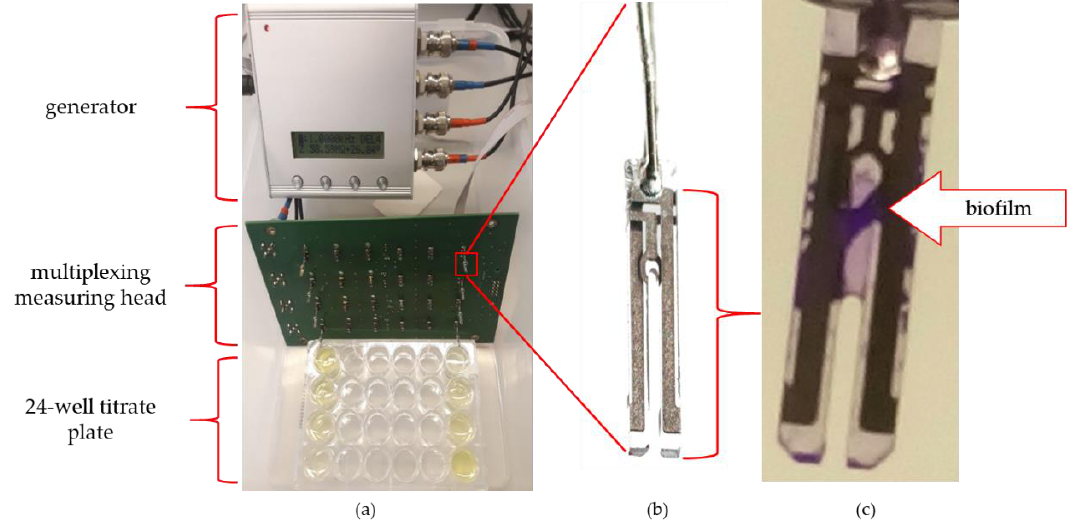
Figure 1. The measurement setup: ( a ) measurement system; ( b ) quartz tuning fork (QTF) senor; ( c ) biofilm covered QTF surface detected by crystal violet (CV) staining.